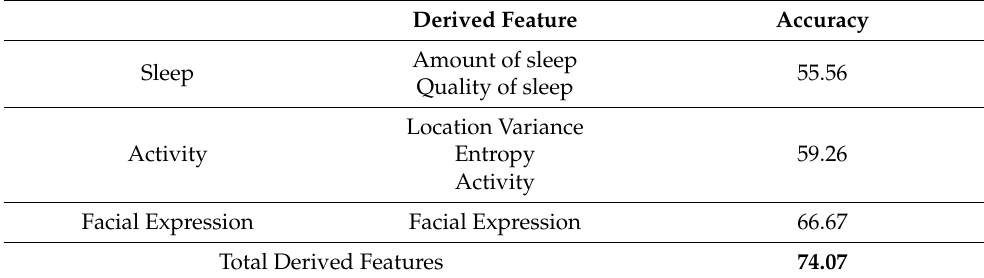
Table 4. Accuracy by Derived Features. The table shows the accuracy of the test data for each derived feature we designed. When all the derived features are combined, 74.07% accuracy is obtained.